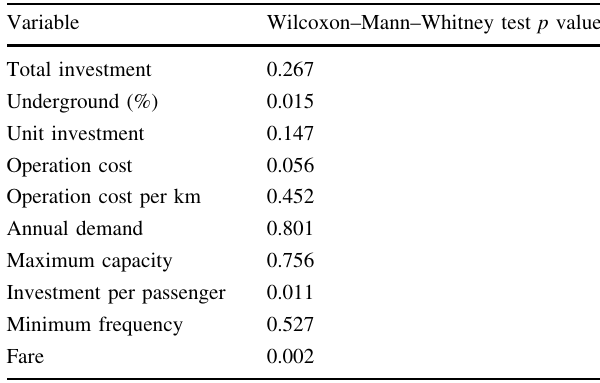
Table 4 Non-parametric test of equality of distributions